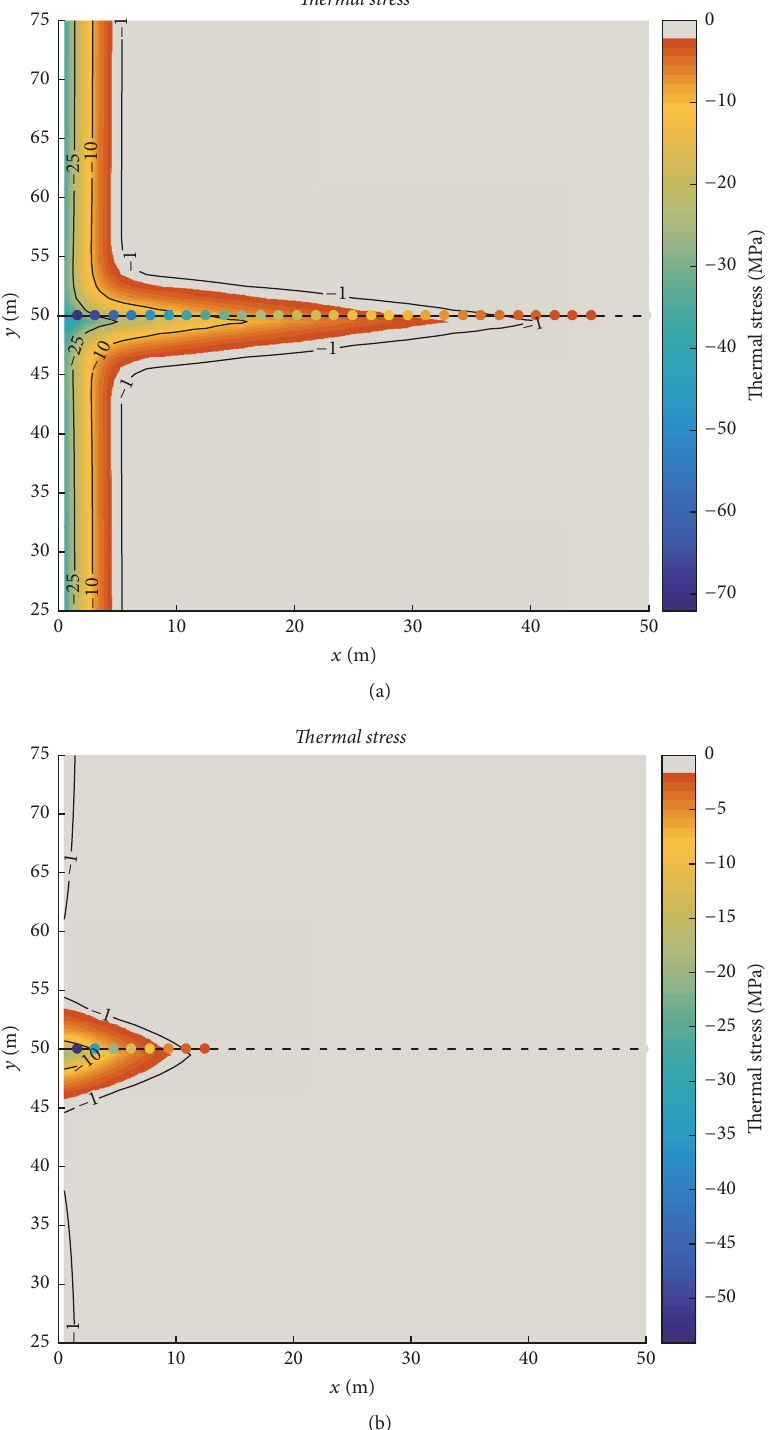
Figure 7: Thermal stress distribution after 30 days of injection. Fracture permeability 𝑘 fr = 10 −10 m 2 : (a): higher matrix permeability 𝑘 𝑚 = 10 −16 m 2 ; (b): lower matrix permeability 𝑘 = 10 −18 m 2 𝑚